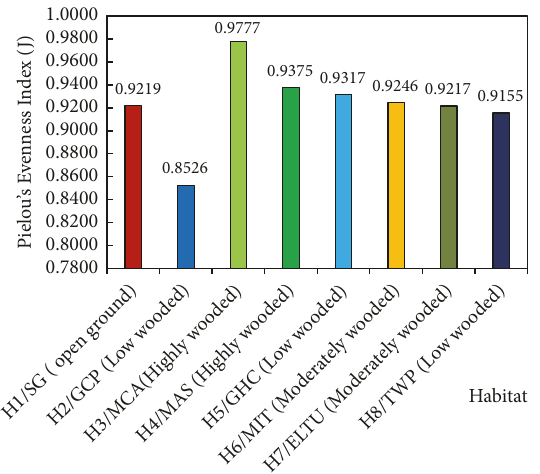
Figure 6: Variation of Pielou’s evenness index (J) among habitats.